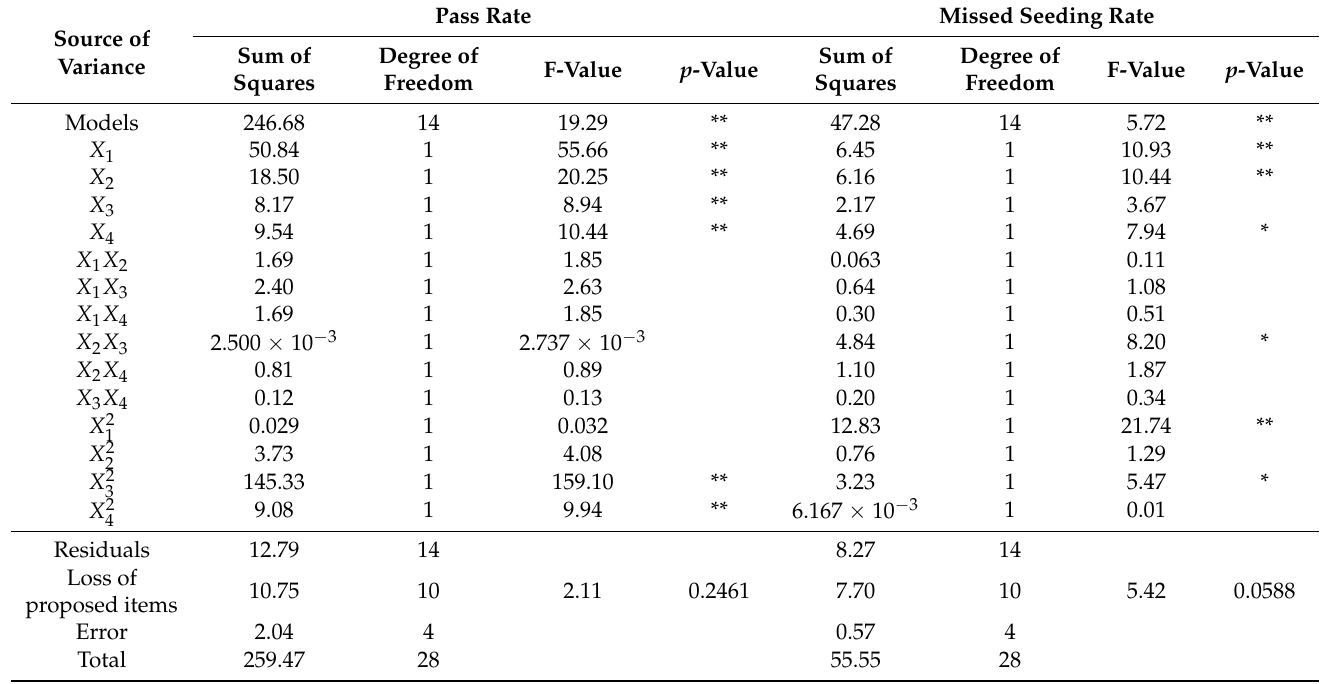
Table 6. Variance analysis of regression